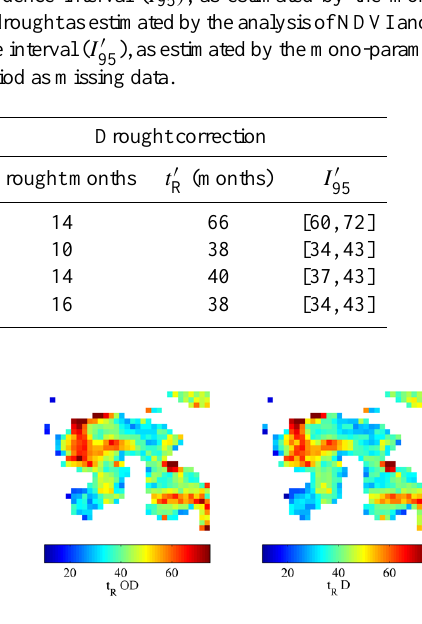
Fig. 8. Recovery time ( t R ) fields over burn pixels in A3, computed by applying the mono-parametric vegetation recovery model, pixel by pixel, to the original dataset (left panel, OD), to the dataset with values corresponding to the drought period as no-value data (cen- tral panel, D) and the difference between recovery time fields (right